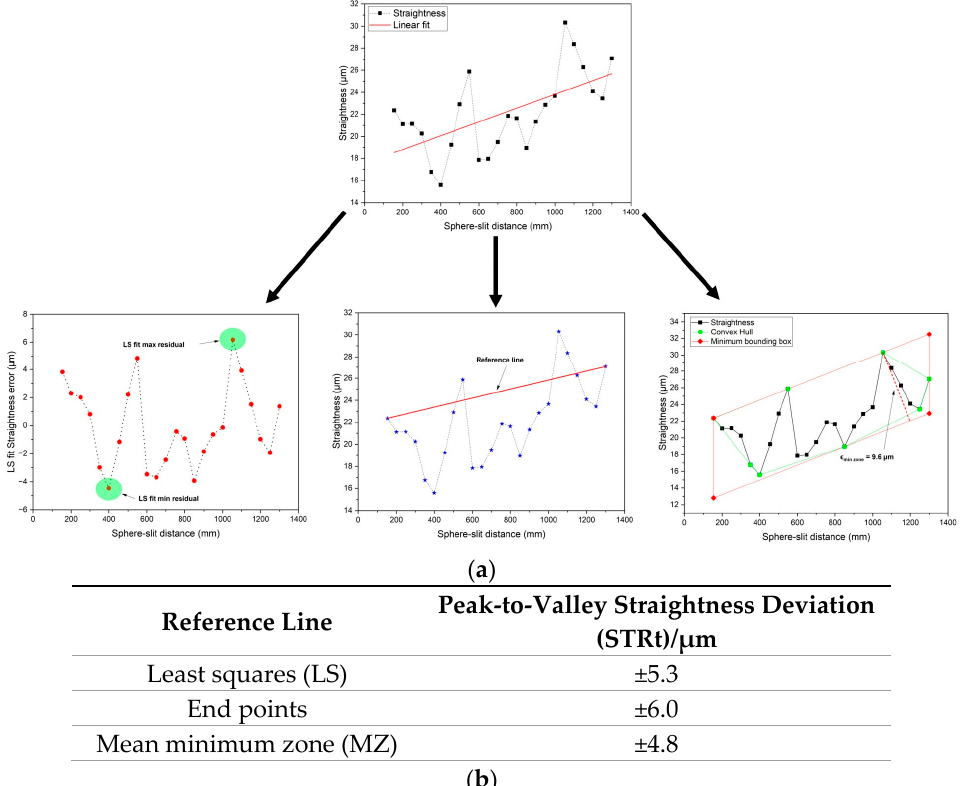
Figure 16. Characterization of the instrument internal reference line. Plots of the straightness vs. the distance between target and slit ( a ) and derived values of the peak-to-valley straightness deviation (STRt) ( b ).